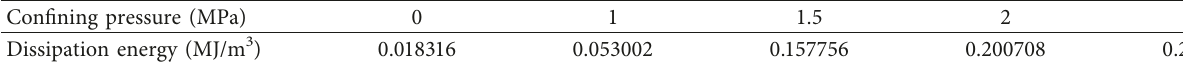
Table 4: Dissipation energy under different confining pressures.